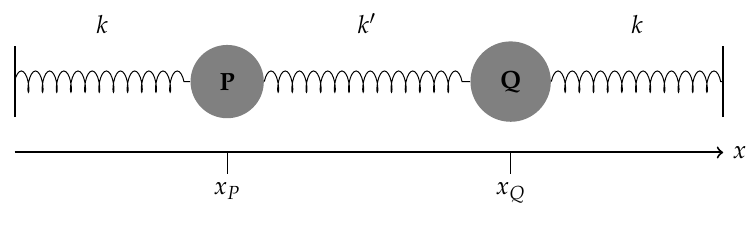
Figure 2. 1D Coupled